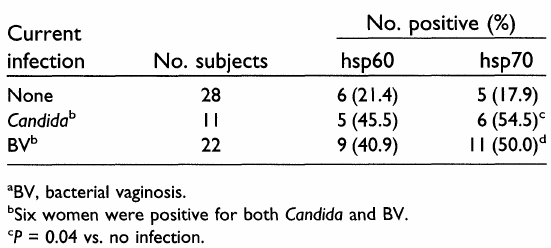
TABLE I. Vaginal infections in study subjects Number of subjects (%) History of Infection